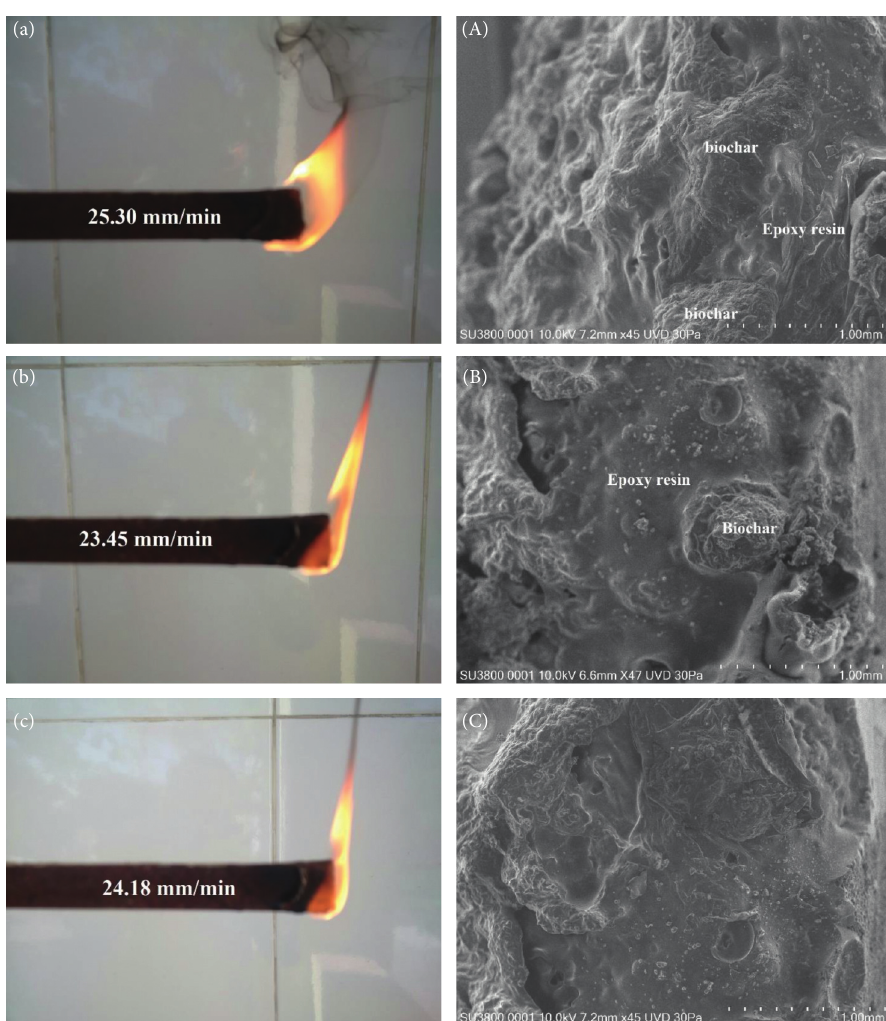
Figure 7: UL94-HB test image and SEM surface image after burning: (A, a) 10 wt%, (B, b): 20 wt%, and (C, c) 30 wt% litchi